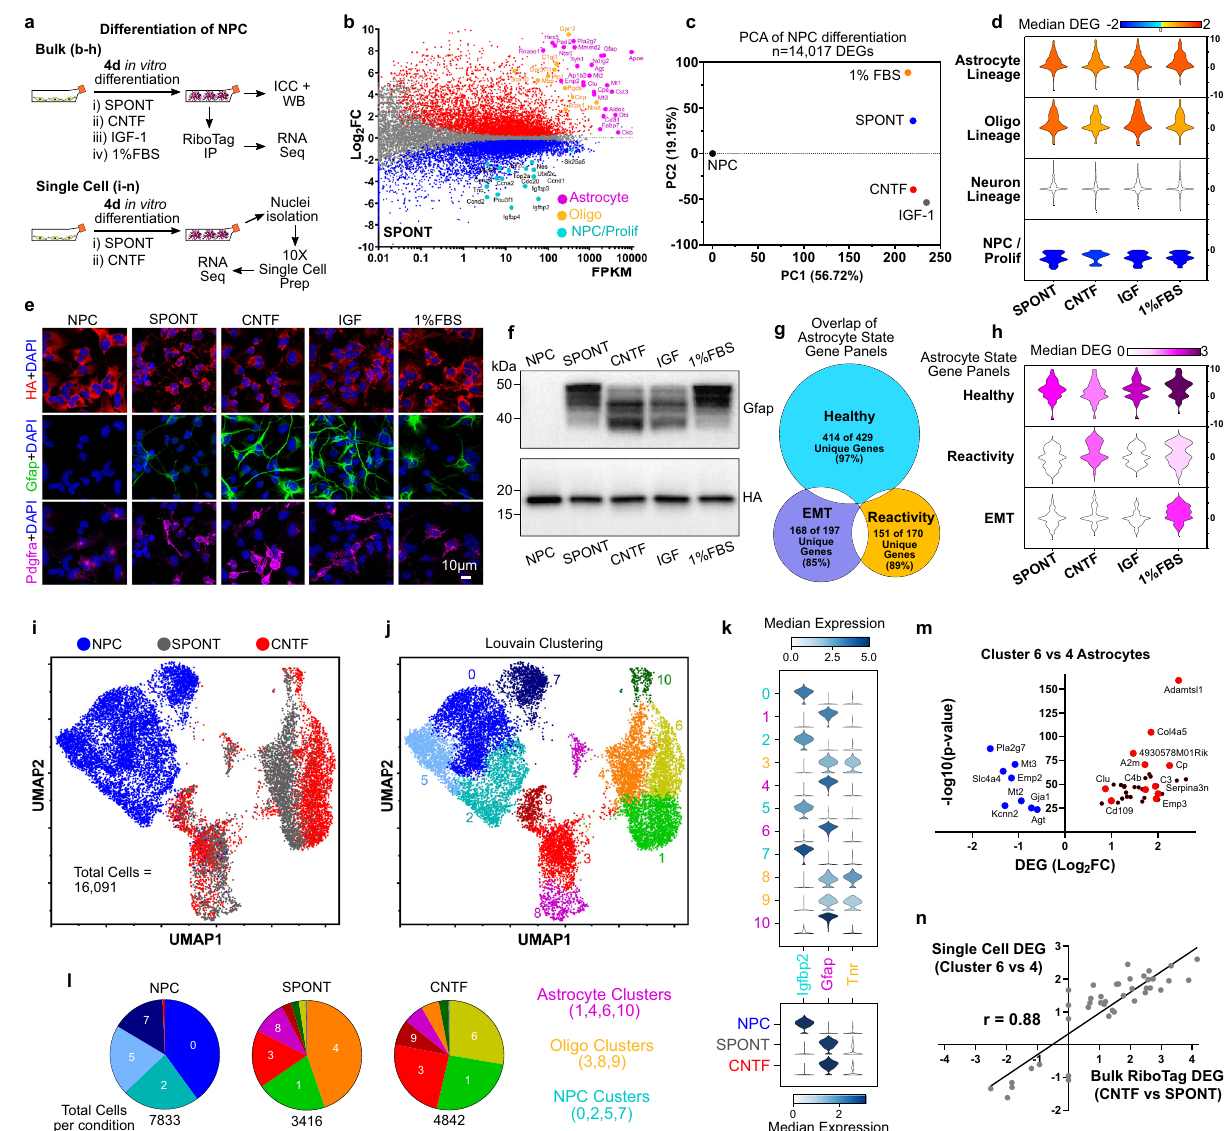
Fig.2|NPCcellautonomouslydifferentiateintoastrocyteandoligodendroglia lineage cells in vitro with phenotype modulated by speci fi c molecules. a SchematicofexperimentalapproachforevaluatinginvitroNPCdifferentiation. b M – A Plot of Spontaneous (SPONT) differentiation referenced to NPC ( N =4 samples) showing increased expression of astrocyte and oligodendroglia lineage genes and decreased expression of NPC/proliferation genes. c PCA of all DEGs associated with NPC differentiation across the conditions referenced to NPC showing large differences for all differentiation conditions compared to the NPC state and variation amongst the unique differentiation conditions. d Violin plots of DEGs for neural cell-speci fi c gene panels. The color of violin plot re fl ects the value of the median DEG for speci fi ed gene panel. e ICC staining of the differentiation conditions for astrocyte (Gfap) and oligodendroglia (Pdgfra) markers. All DAPI-positive cells across differentiation conditions are RiboTag (HA) positive. f Western blot for Gfap and HA showing variation in Gfap isoform bands amongst the various differentiation conditions. HA expression is not altered by differentiation condition. g Venn diagram of genes for the different astrocyte states derived through meta-analysis of published datasets showing minimal overlap of healthy astrocyte, reactivity and EMT genes. h Violin plots of DEGs from the healthy astrocyte, reactivity, and EMT gene panels that are amongstthetop2000mostdifferentiallyexpressedgenesforthedifferentiation